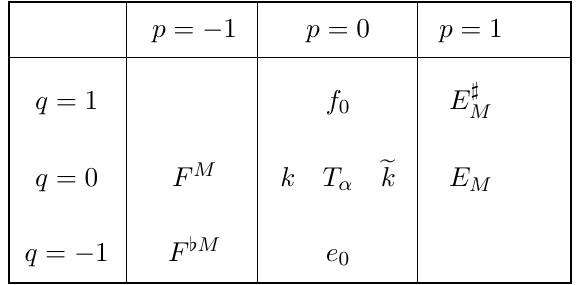
Table 1 . The general structure of the superalgebra B ( g + ). Red lines are the usual levels n = p (cid:0) q in the level decomposition of B ( g + ), and form g + -modules.